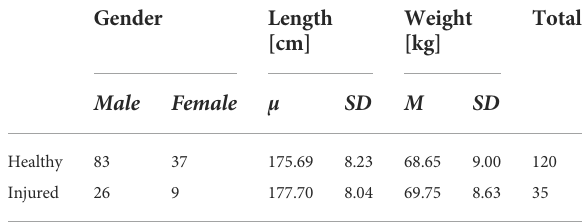
TABLE 1 Statistics about the available dataset. The average is denoted as μ andthestandarddeviationas SD .Onlythehealthypeopleand theoneswithlowerextremityoveruseinjuriesareincluded.Allpeople thathadanunknowninjurytype,missing/incorrectvaluesoranacute injury are omitted from this table.